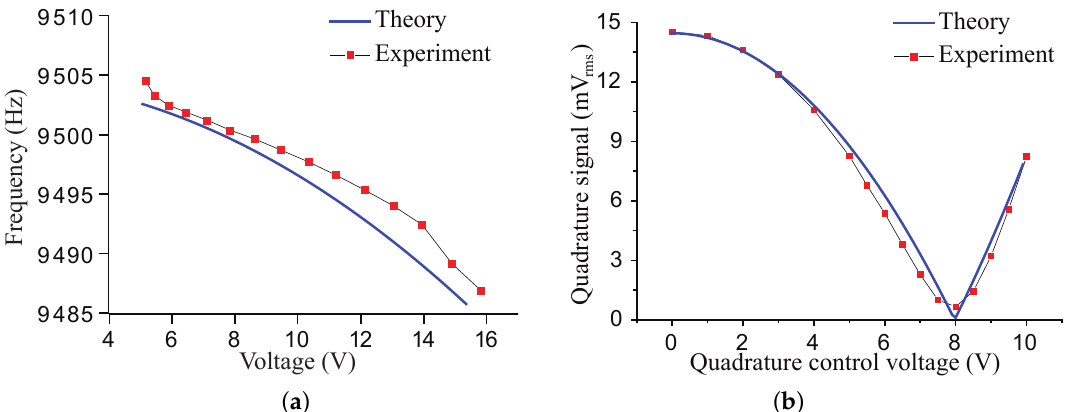
Figure 14. ( a ) The mode softening. ( b ) The relationships between the quadrature signal and the quadrature control